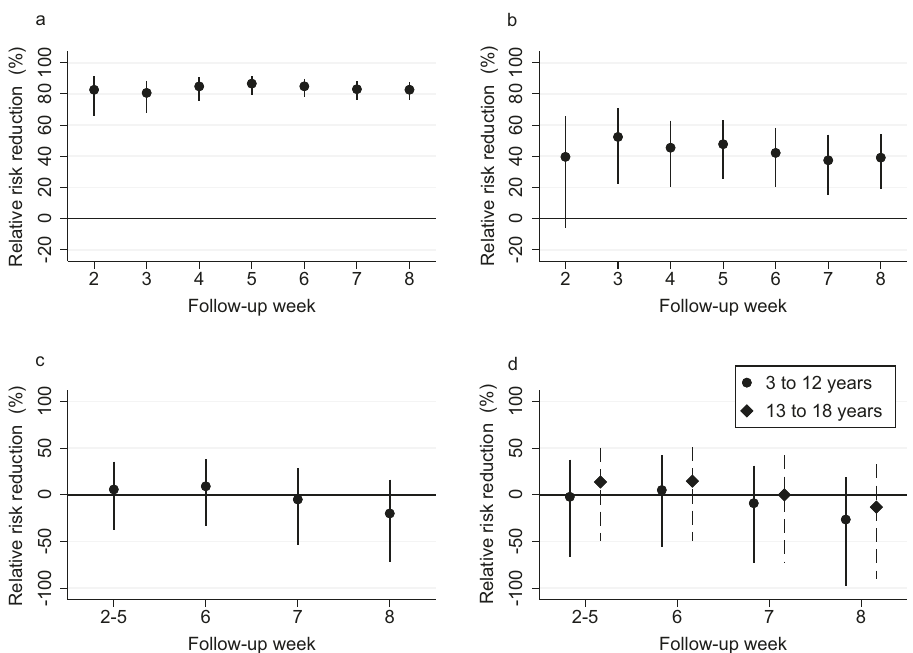
Fig. 3 Vaccine effectiveness among fully (double) vaccinated healthcare workers and their unvaccinated partners and children living in the same household after the second vaccine dose. This fi gure plots the vaccine effectiveness estimates by week after the second dose of mRNA-based